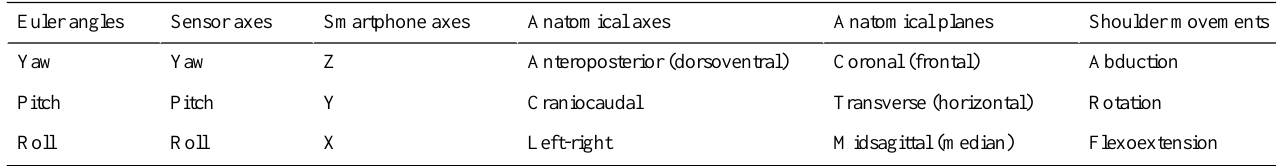
Table 1. Equivalence between the inertial sensor and smartphone placed on the humerus and the anatomical interpretation for shoulder movements.